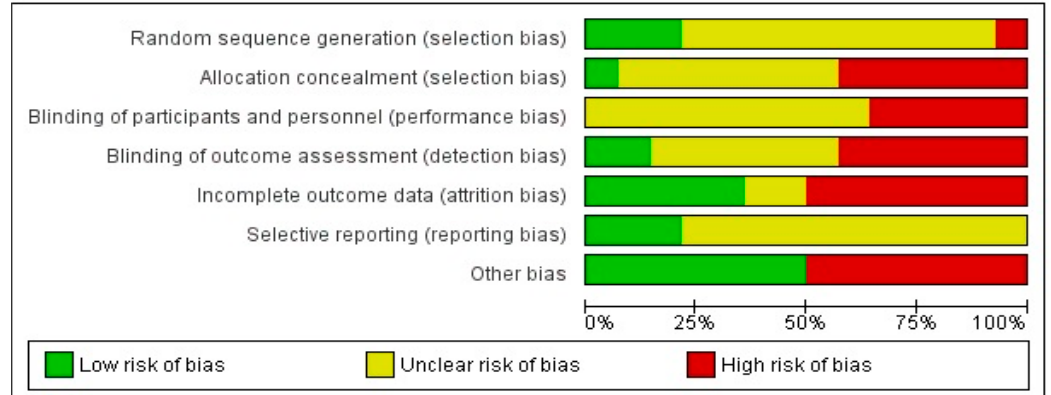
Figure 2. Risk of bias summary: review authors’ judgments about each risk of bias item for each included intervention study. Red, yellow, and green circles represent high, unclear, and low risk of bias, respectively.